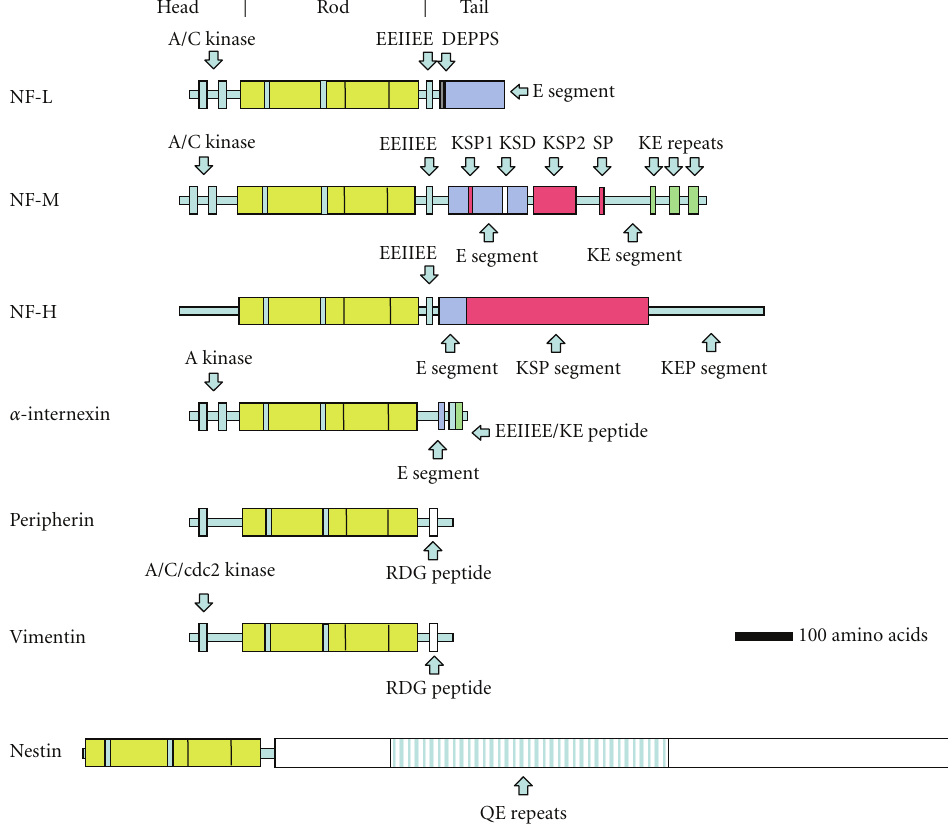
Figure 1: Diagram of the subunit proteins of neurofilaments. NF-L, NF-M, NF-H, and α -internexin can be regarded as the major subunits of adult NFs though NFs may also contain peripherin, vimentin, and nestin in certain locations, developmental stages, and possibly damage or disease states. Phosphorylation sites for protein kinase A (A kinase), protein kinase C (C kinase), and cdc2 kinases (cdc2 kinase) have been characterized in the globular “head” regions of certain of these molecules as indicated. The regions indicated by KSP, SP, KSD, and DEPPS are known serine phosphorylation sites in the “tail” regions. EEIIEE, KE repeats, Tail a, E segment, KEP segment, KE segment, RGD, and QE repeats each refer to specific kinds of sequence motif. For further details, see Shaw 1998